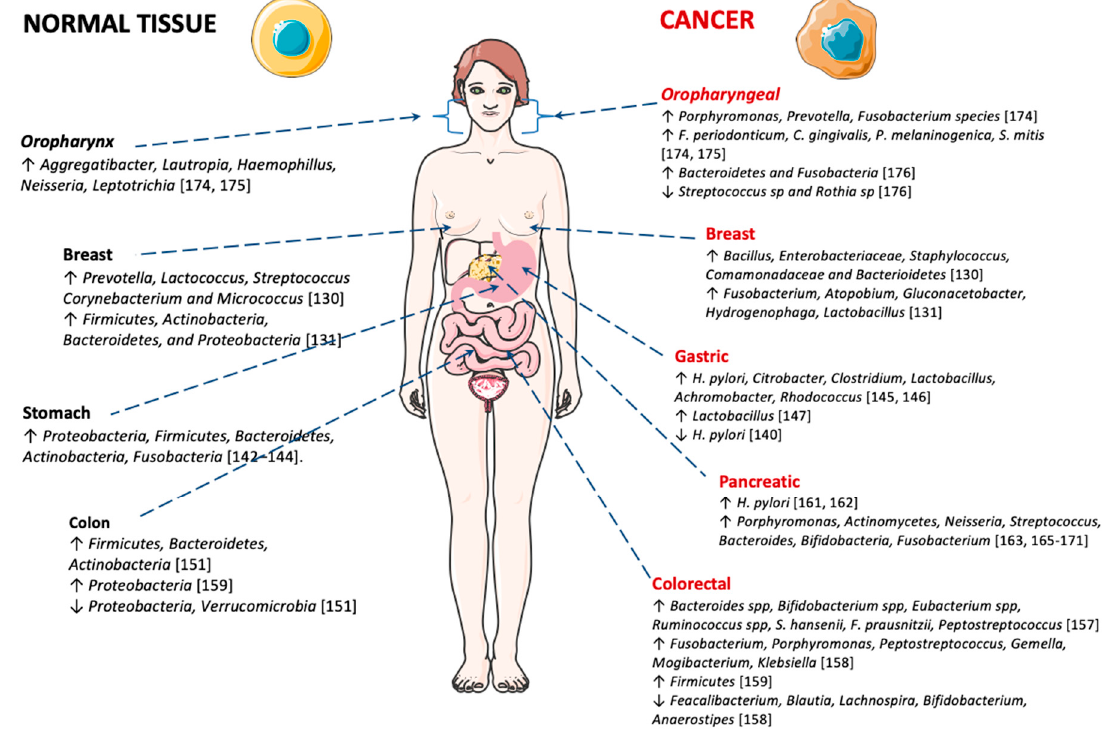
Figure 2. Microbiota in normal and cancer tissues. This figure was produced, in part, using Servier Medical Art (https://smart.servier.com).